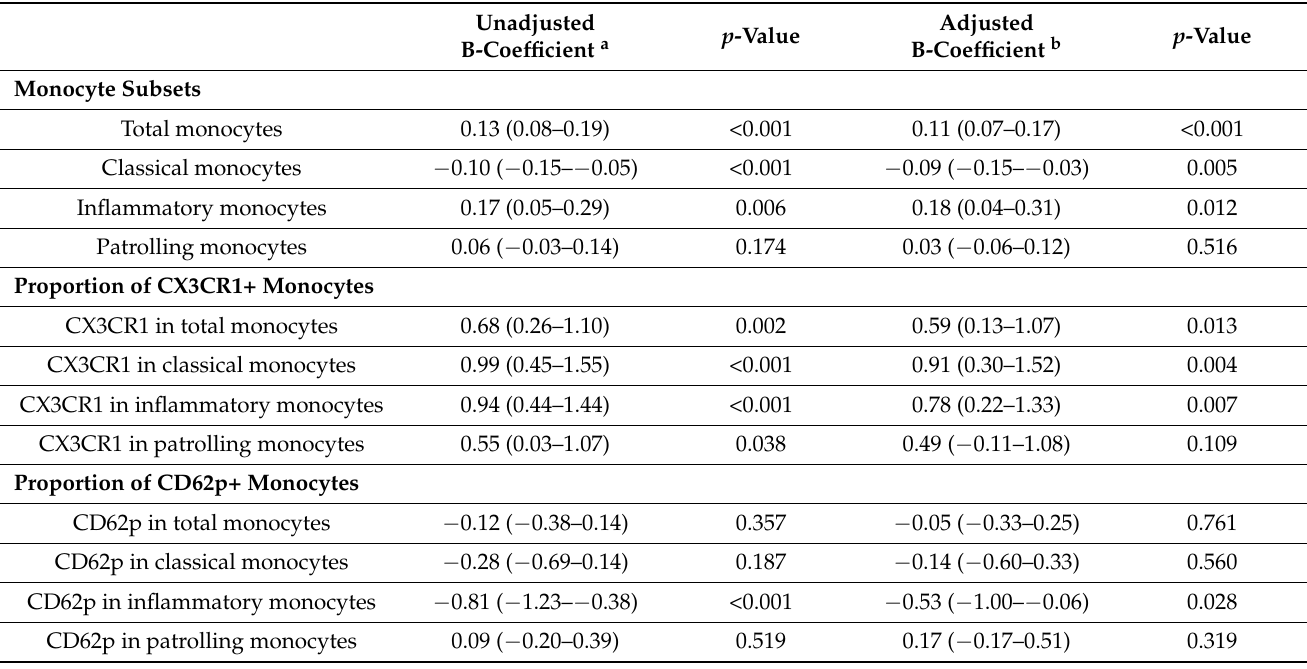
Table 2. Association between HIV infection and total monocytes, monocyte subsets, and surface expression of CX3CR1 and